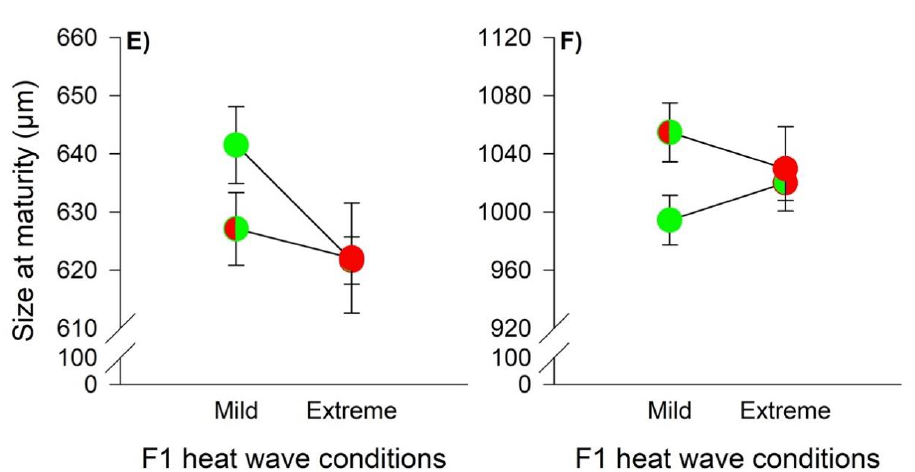
Figure 5. Heat wave effects during juvenile development on the leaf damage, age at maturity, and size at maturity of males ( A , C , E ) and females ( B , D , F ) of the prey T. urticae . The circles illustrate the